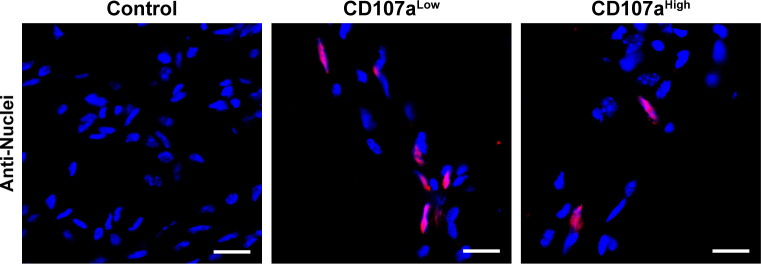
Persistence of human CD107alow and CD107ahigh cells within intramuscular implants within NOD-SCID mice.Sections were obtained at 8 weeks post-implantation, and immunofluorescence staining of human-specific nuclei performed within CD107alow or CD107ahigh laden implants, in comparison to acellular control. White scale bar: 20 μm. N = 8 implants analyzed per treatment group.